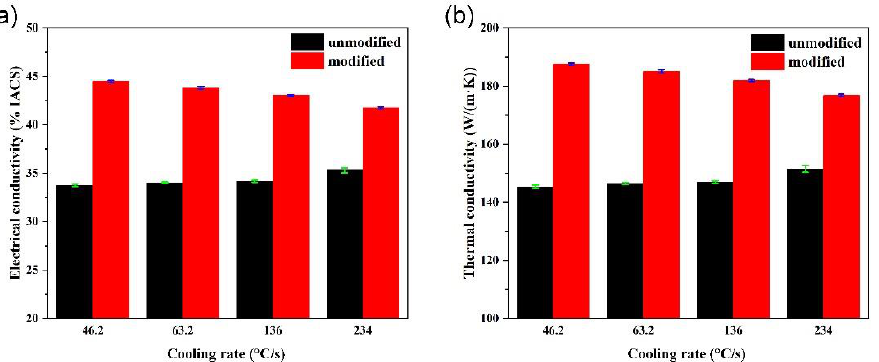
Figure 5. Properties of samples (with and without Sr) under different cooling rates: ( a ) electrical conductivity and ( b ) thermal conductivity.